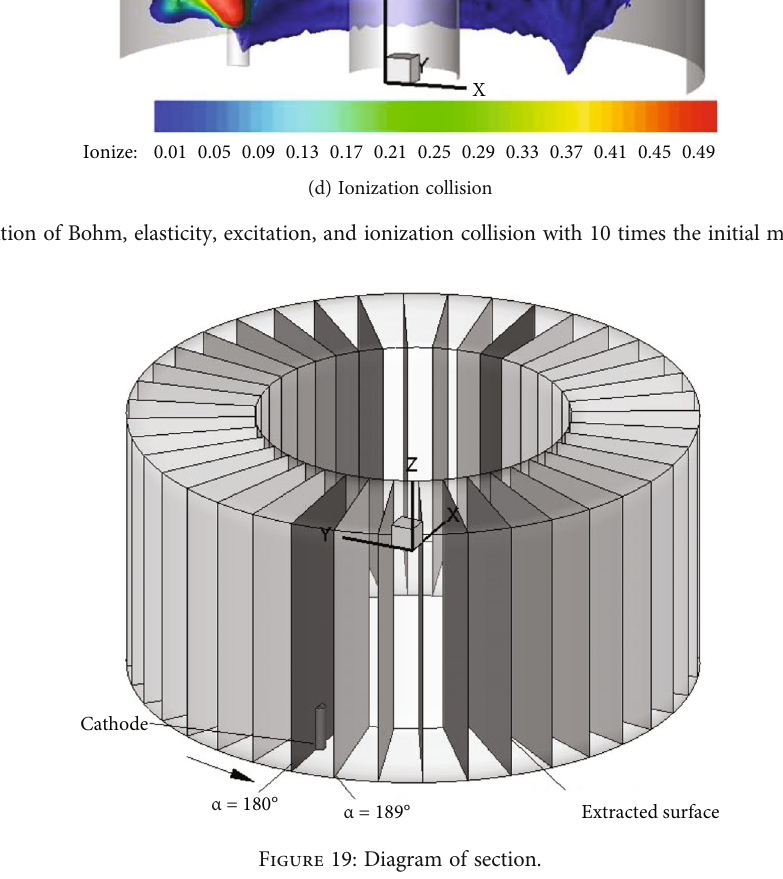
Figure 19: Diagram of